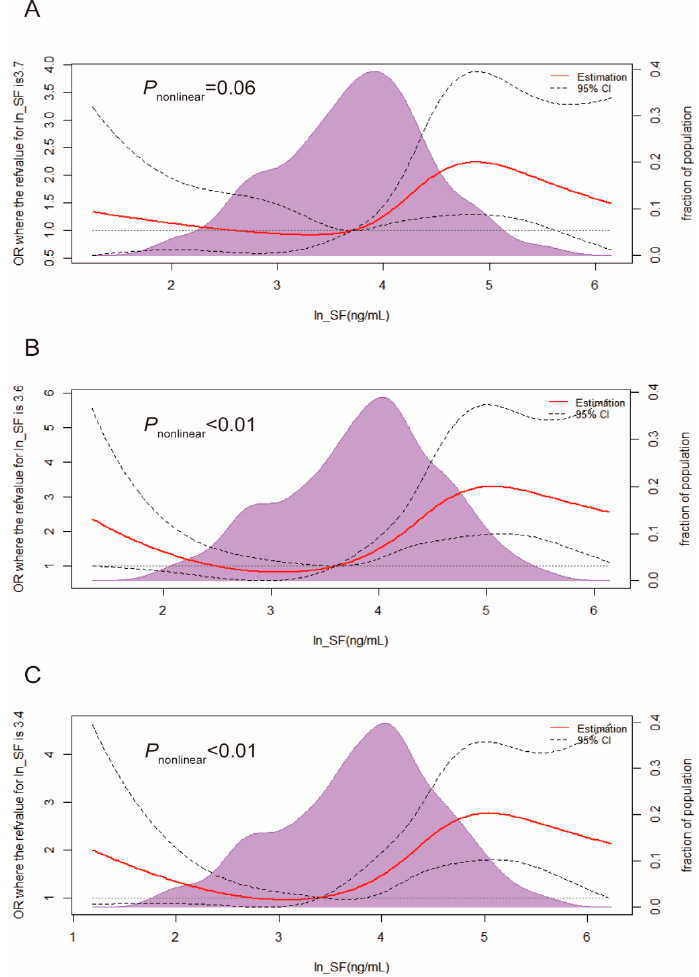
Figure 1. Restricted cubic spline regression analysis for the association between SF and IGM ( A ), T2DM ( B ), and hyperglycemia ( C ). The analysis was adjusted for age, education, race, smoke, drink, exercise, BMI, WC, SBP, DBP, TC, TG, HDL-C, LDL-C, UA, hemoglobin, hsCRP, and AAG. Abbre- viation: CI, con fi dence interval; IGM, impaired glucose metabolism; T2DM, type 2 diabetes